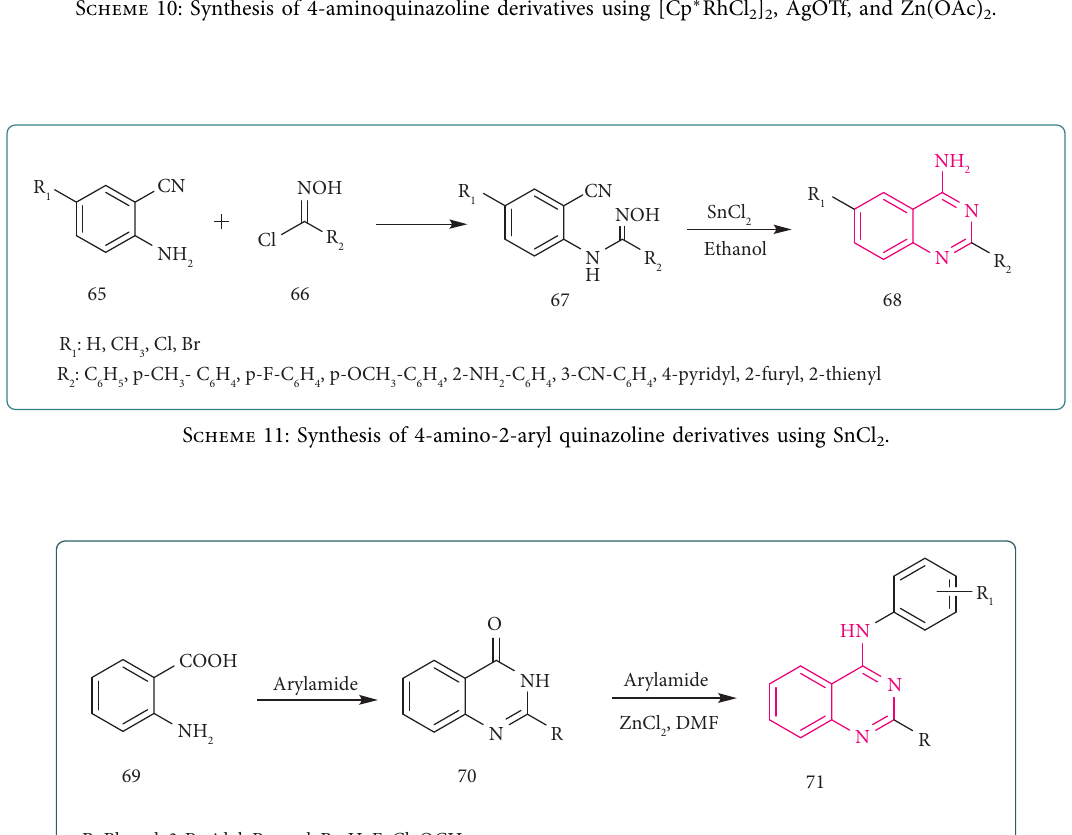
2 Figure 11. Te iron-mediated [3+2] cycloaddition of benzo- nitriles with NaN produces 85 which undergoes copper-cat- 3 alyzed S Ar reaction and generates 86 . Ten, consecutive N reduction, cyclization, oxidation, and copper-catalyzed